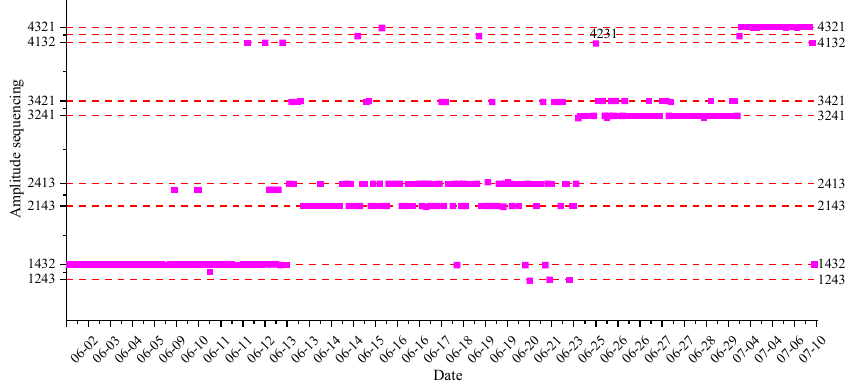
Figure 4. Amplitude sequencing results in the four different periods.